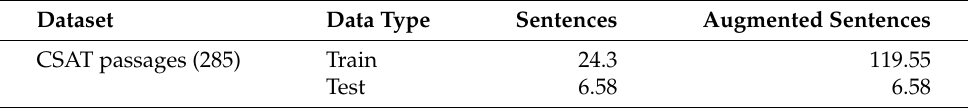
Table 4. Dataset details.